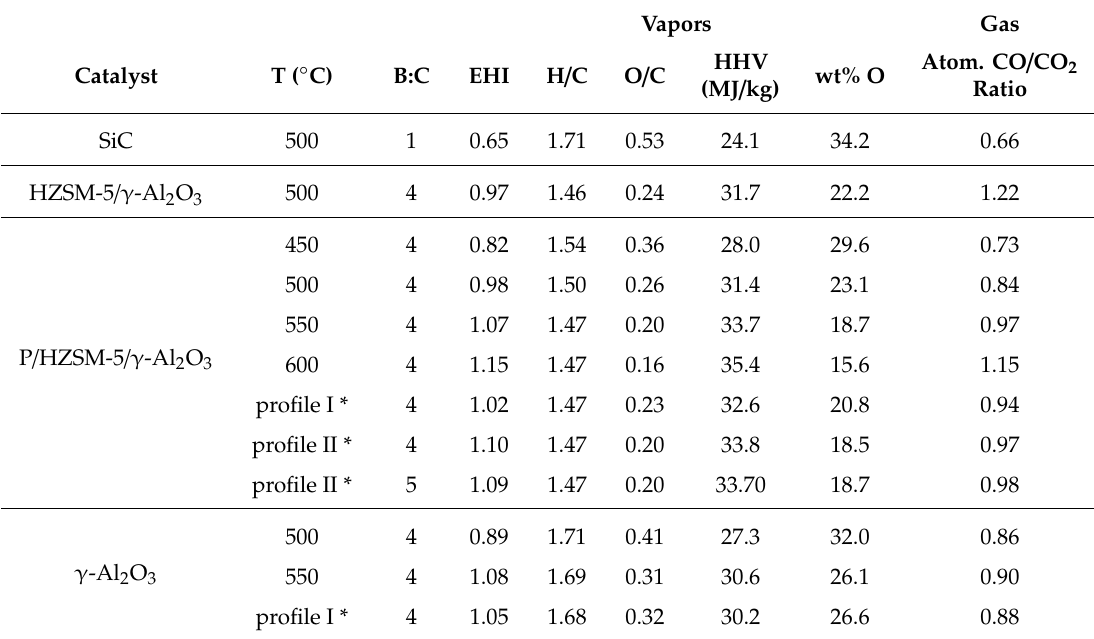
Table 3. Properties of the accumulated non-condensed vapors at the indicated B:C ratios that are important for fuel applications. In addition, the atomic CO / CO 2 ratio in the gas is shown. Vapors Gas Catalyst T ( ◦ C)